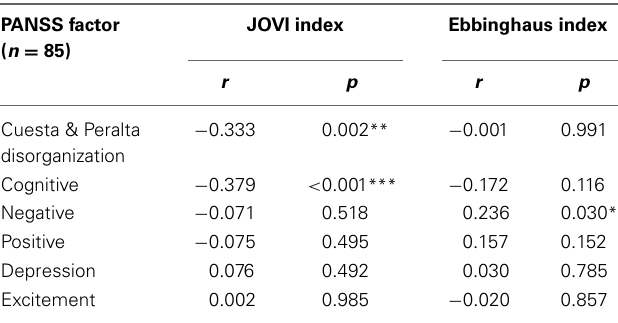
Table 3 | Spearman correlations of PANSS factors and perceptual organization task indices.